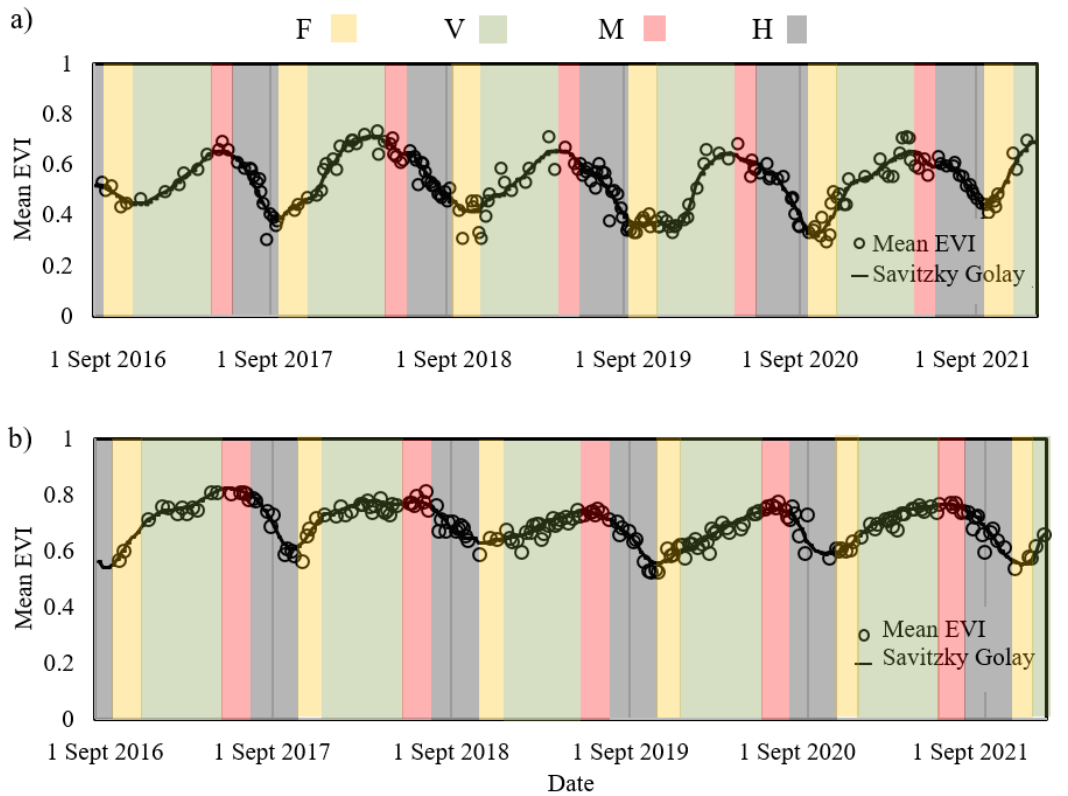
Figure 5. Savitzky – Golay (SG)-smoothed curve fitted to Sentinel 2 (S2) time-series EVI data over five years (2017 – 2021) for the ( a ) Bundaberg (four blocks) and ( b ) Renmark (three blocks) avocado farms. The four different colors show the four phenological stages (i.e., F, V, M, and H) according to the calendar months.